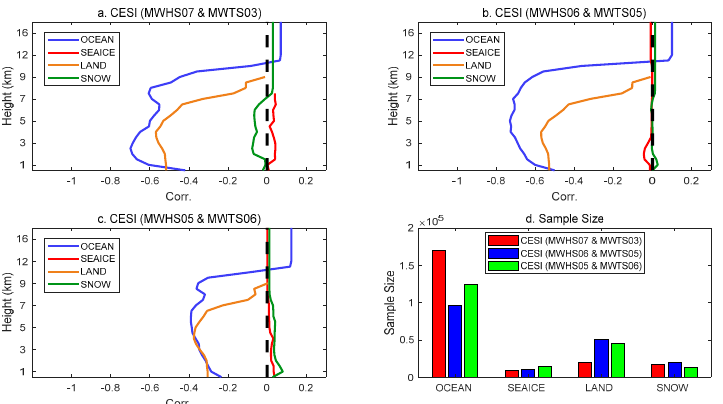
Figure 10. Same as Figure 9 except for the liquid profile correlation. The subfigures ( a – c ) represent results for CESI low , CESI mid and CESI high , respectively. The sample size after collocation over different surface types is shown in ( d ).